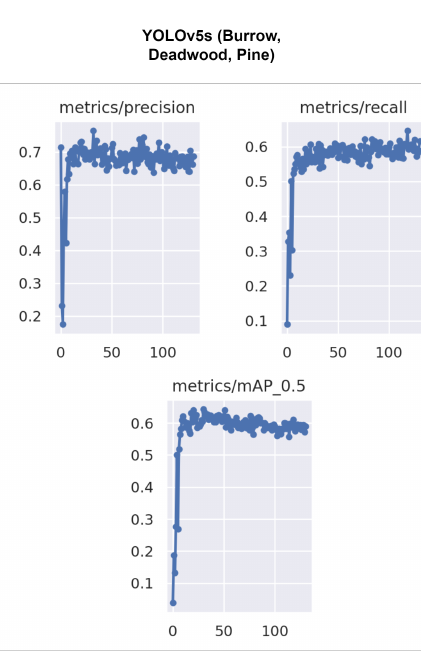
Figure 13. The person detection from drone in thermal and RGB images.